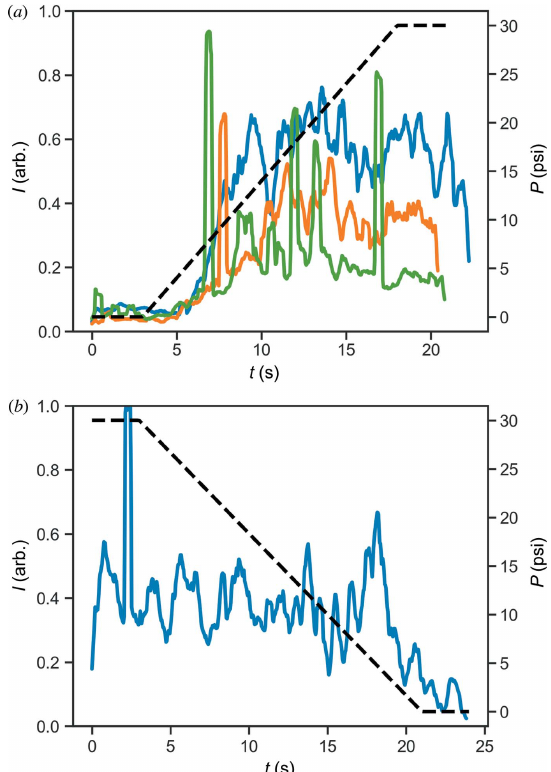
Figure 7 Intensity of light transmitted through the sample stream 100 m m from the nozzle tip as a function of time, as the stabilizing gas flow is varied. Black dashed line shows the approximate backing pressure of the gas jet. High transmission is indicative of the presence of lamellar phase while low transmission indicates the sample is in a cubic phase. The sample composition is 60:40 MO/water ( w / w ). ( a ) Gas backing pressure is reduced slowly to zero prior to collecting data, then increased steadily from 0 psi to 30 psi. A significant increase in intensity is observed, indicating a transition to the lamellar phase. This was repeated three times to show the procedure was reproducible. ( b ) Gas backing pressure begins at 30 psi and is reduced steadily to zero. The corresponding decrease in transmission indicates reversion to LCP as the gas flow is